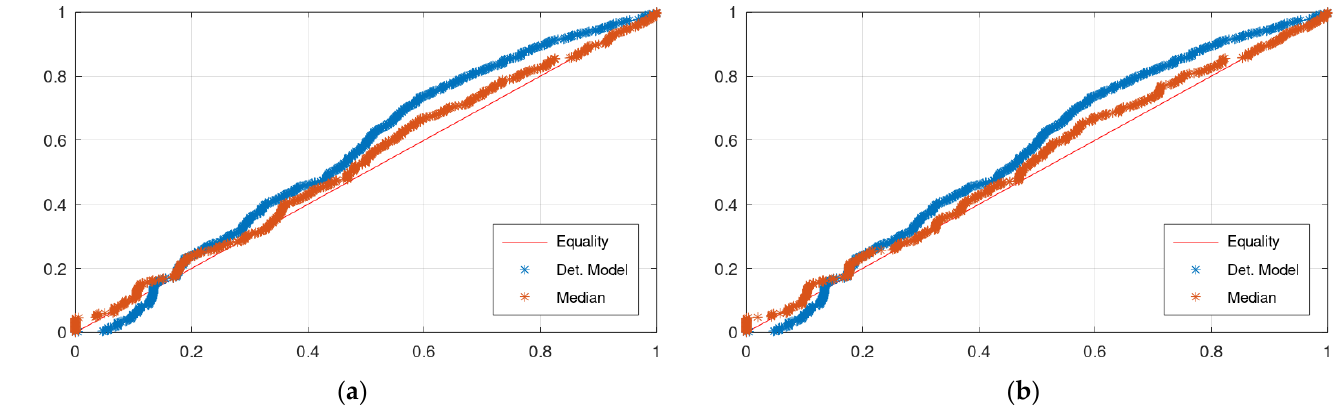
Figure 4. CPP plots of the Arno River case study: ( a ) KNN; ( b ) Bluecat. “Det. Model” is the simulation with HyMod.